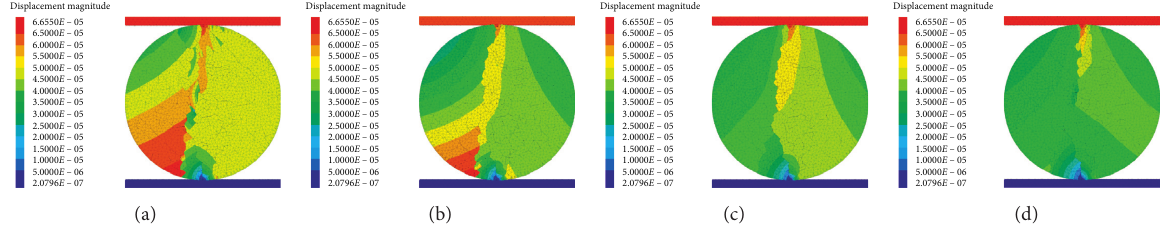
Figure 25: Cloud maps of splitting displacement of 45 ° bedding shale with different contact cohesion. (a) 0.8 times. (b) 1 time. (c) 1.2 times. (d) 1.5